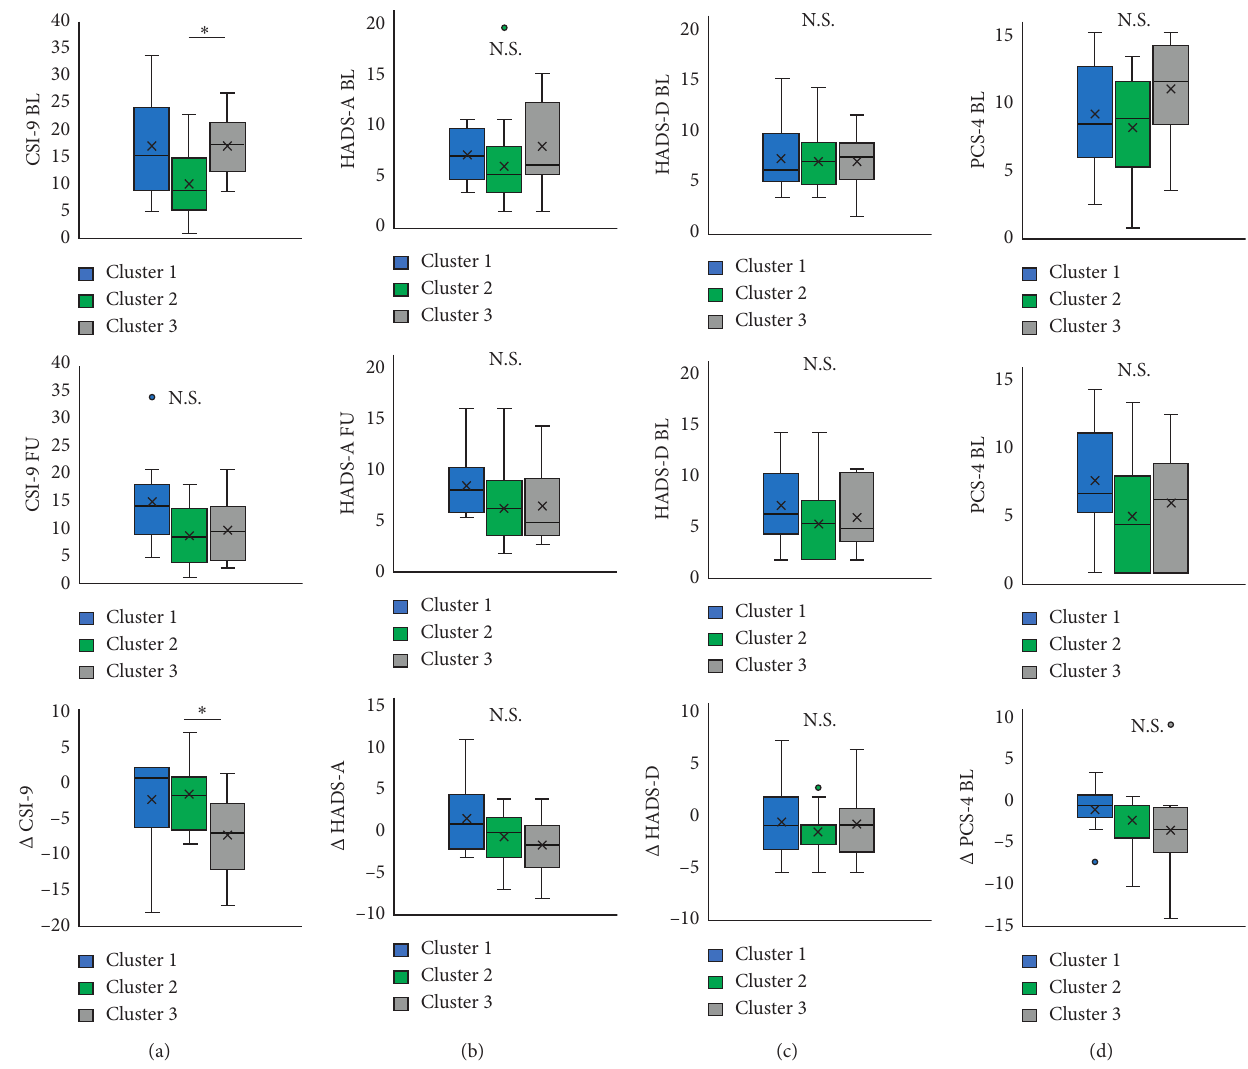
Figure 4: The difference of CSI-9, HADS-A, HADS-D, and PCS-4 between clusters. (a) The difference of CSI-9 between clusters. (b) The difference of HADS-A between clusters. (c) The difference of HADS-D between clusters. (d) The difference of PCS-4 between clusters. ∗ : p < 0 . 05. Abbreviations: CSI-9, Central Sensitisation Inventory-9; HADS-A, Hospital Anxiety and Depression Scale-Anxiety; HADS-D, Hospital Anxiety and Depression Scale-Depression; PCS-4, Pain Catastrophising Scale-4; BL, baseline; FU, follow-up; ∆ , follow-up score minus the initial